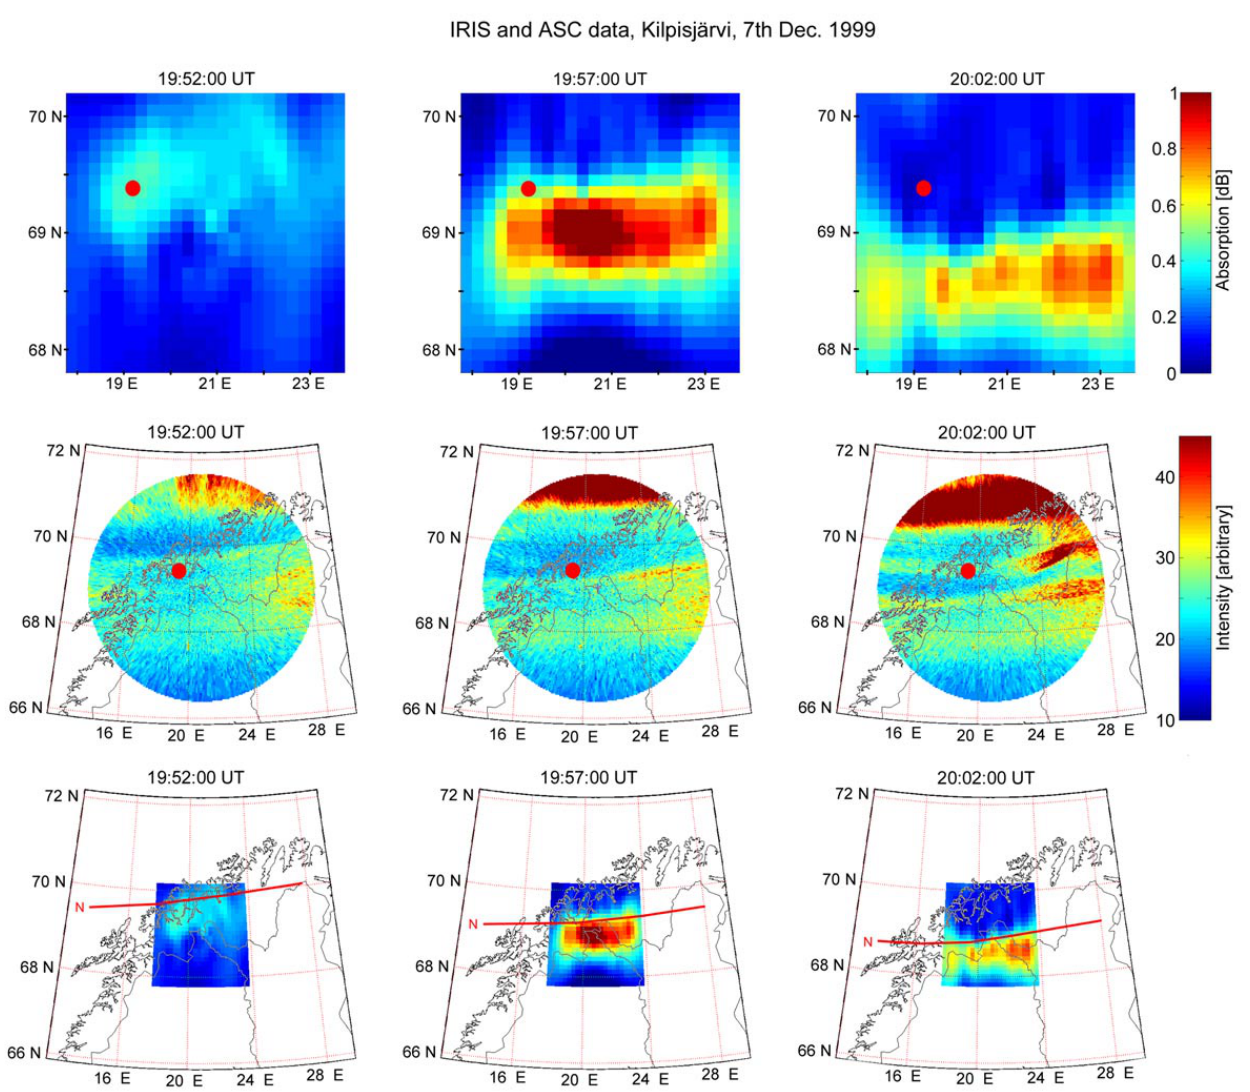
Fig. 2. Absorption, optical and combined data from three selected times from Event 1 on 7 December 1999. The top panel shows the colour coded absorption from IRIS mapped to the longitude-latitude grid to the 80km altitude. The maximum for the absorption is 1dB. The middle panel shows the whole ASC image, mapped to the longitude-latitude grid, assuming the height of 100km for the structures. The bottom panel shows the combined IRIS and ASC data. Only the location of the edge (N for northern edge, S for southern edge, depending on the location of the arc referred to the site) of the arc is shown with the absorption